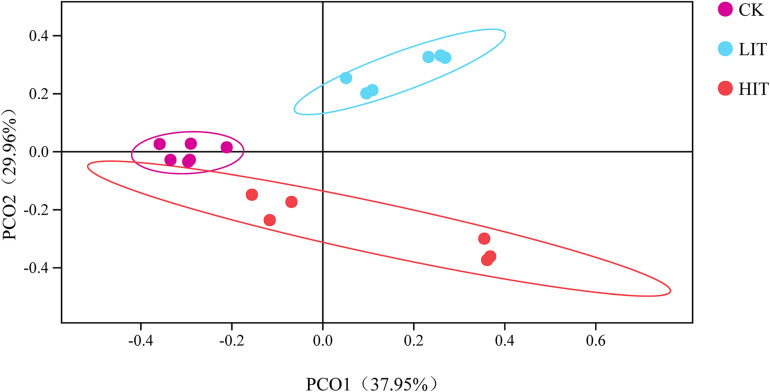
Principal coordinate analysis of the fungal community based on Bray–Curtis distance among different groups. The circle represents the 95% confidence interval.